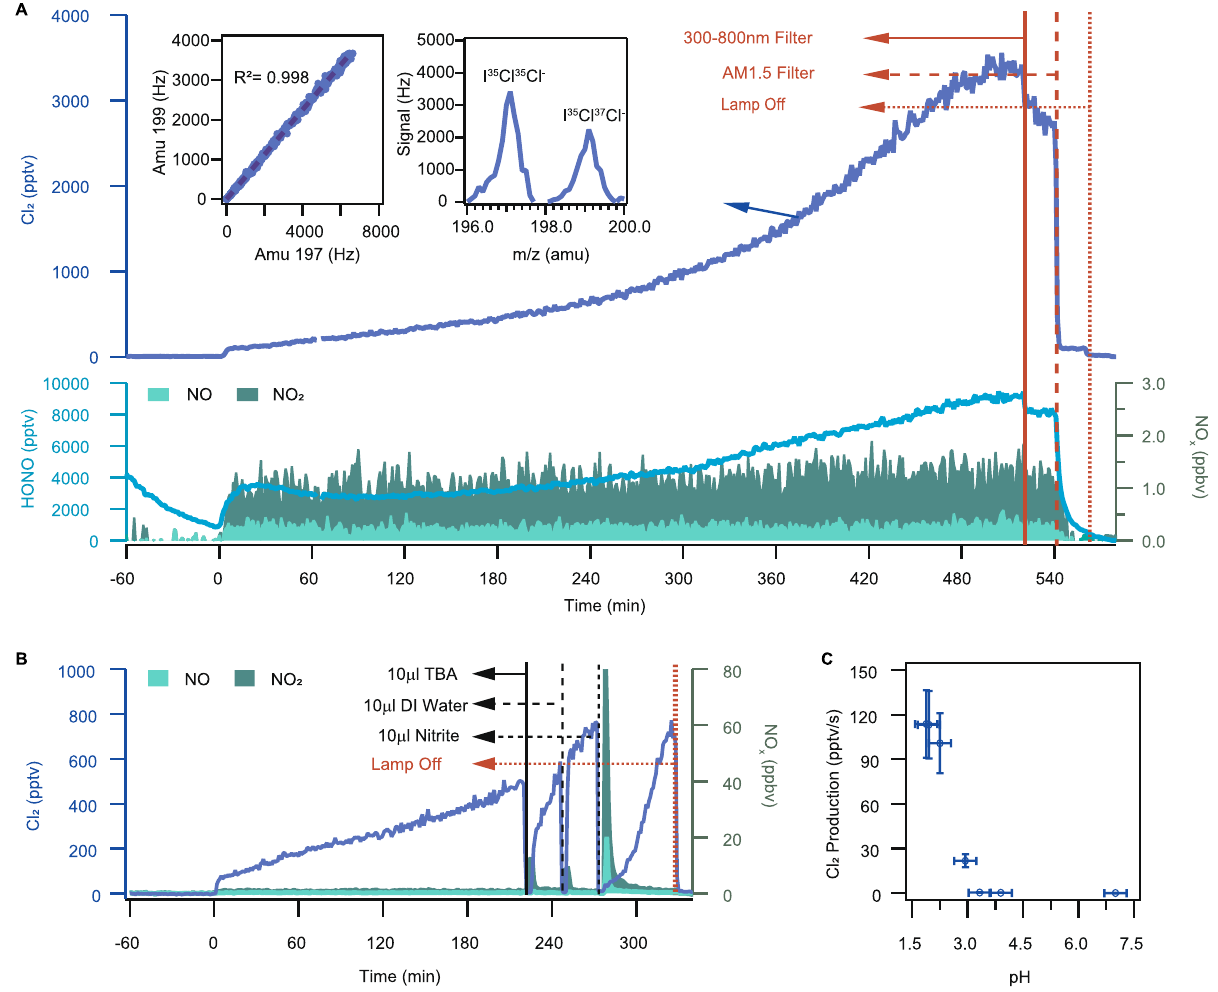
Fig. 2 Experimental results on solutions in the dynamic chamber. A Time series of 1-min average mixing ratios of Cl 2 , HONO, and NO x. The liquid solution samples (pH = 1.9) were illuminated at t = 0. The solid red line shows the time at which 300 – 800 nm fi lter was used, the red dashed line indicates the time at which AM1.5 fi lter was used, and the red point line indicates the time at which the xenon lamp was turned off. The left inset: scatter plot of the raw CIMS signal of Cl 2 at mass 199 atomic mass unit (amu) (I 35 Cl 37 Cl − ; I 37 Cl 35 Cl − )) versus 197amu (I 35 Cl 35 Cl − ) with 1-min average from t = − 60 to t = 580min. The right inset: the scanned mass spectra from 196amu to 200 amu at t = 387 min. The continuous increase of Cl 2 may be due to the higher concentration of ions and acidity in the solution due to the evaporation of water from the solution. B Time series of 1-min average Cl 2 , NO, and NO 2. The liquid solution samples (pH = 2.0) were illuminated at t = 0. The solid black line shows the time at which 10 μ l OH scavenger, TBA, was added, the black dashed line indicates the time at which 10 μ l DI water was added, the black point line indicates the time at which 10 μ l nitrite was added, and the red point line indicates the time at which the xenon lamp was turned off. C The production rate of Cl 2 as a function of initial solution pH (pH = 1.9; 2.0; 2.3; 2.9; 3.3; 3.9; 6.8) at the illumination time of 500 min. The error bars in the plot ( C ) represent the estimated uncertainty in Cl 2 and pH measurement. Experimental conditions: 75 − 83% RH, 298K in air and one 4 ml liquid solution containing 1 M NaCl + 1 M NaNO 3